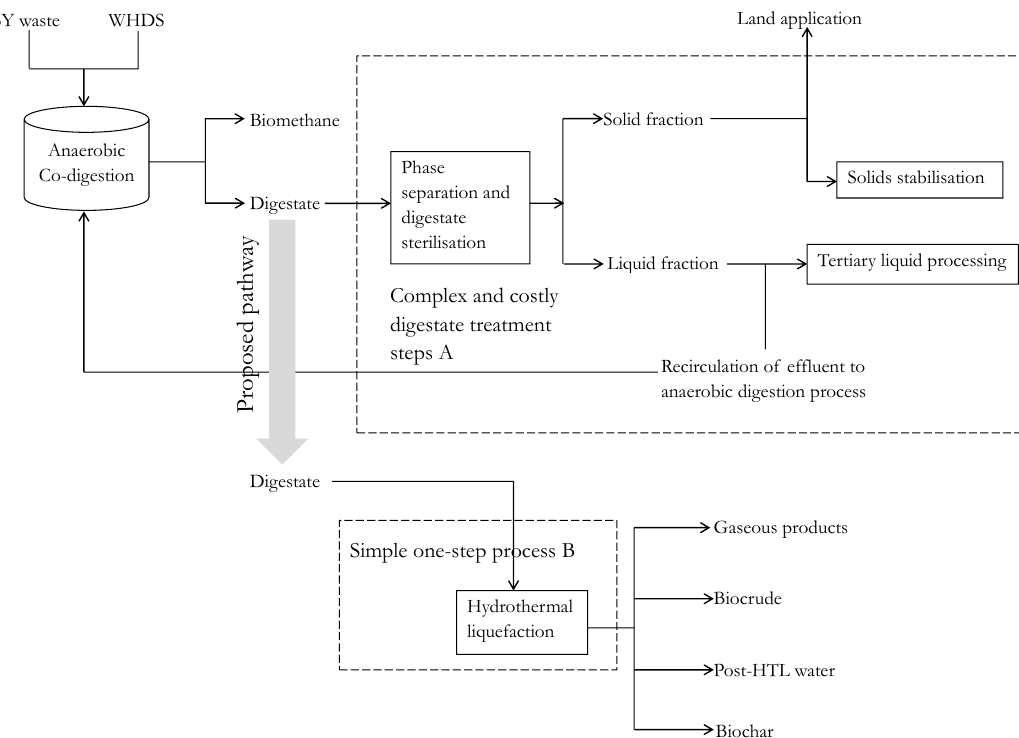
Figure 1. Proposed enhanced resource recovery step B compared to traditional digestate handling technologies A: SY, WHDS and HTL denote stockyard, wet hydrolyzed dissolved air flotation DAF sludge and hydrothermal liquefaction, respectively; SY: stockyard; WHDS: wet hydrolyzed DAF sludge; HTL: hydrothermal liquefaction; DAF: dissolved air flotation sludge.